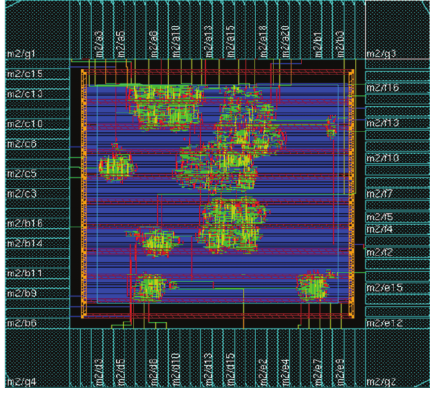
Figure 5: Die image of